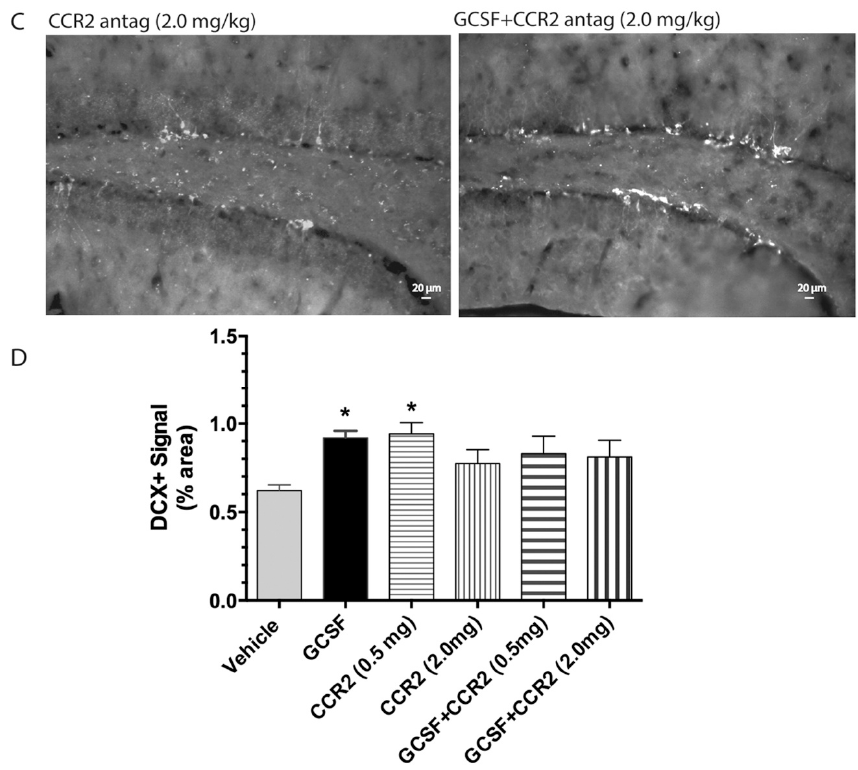
Figure 5. Effects of G-CSF and CCR2 receptor antagonist treatment on the expression of hippocampal doublecortin (DCX), a surrogate marker of neurogenesis. Arrows point to DCX+ cells in the subgranular zone. ( A ) Vehicle ( left panel ) compared to G-CSF treatment ( right panel ); ( B ) CCR2 receptor antagonist (0.5 mg/kg) alone ( left panel ) compared to G-CSF co-administered with the CCR2 receptor antagonist (0.5 mg/kg); ( C ) CCR2 receptor antagonist (2.0 mg/kg) alone ( left panel ) compared to G-CSF co-administered with the CCR2 receptor antagonist (2.0 mg/kg). Scale bar = 20 µm; ( D ) Summary of signal analysis. Mean ± SEM of the DCX+ signal (% of area) is plotted against specific treatment. Both G-CSF administered alone, and the CCR2 receptor antagonist administered alone increased the DCX signal in the subgranular zone of the hippocampus compared to vehicle treatment. One-way ANOVA was followed by Sidak’s correction for multiple comparisons (* p < 0.05).